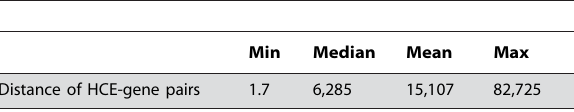
The distances were measured from midpoint to midpoint.